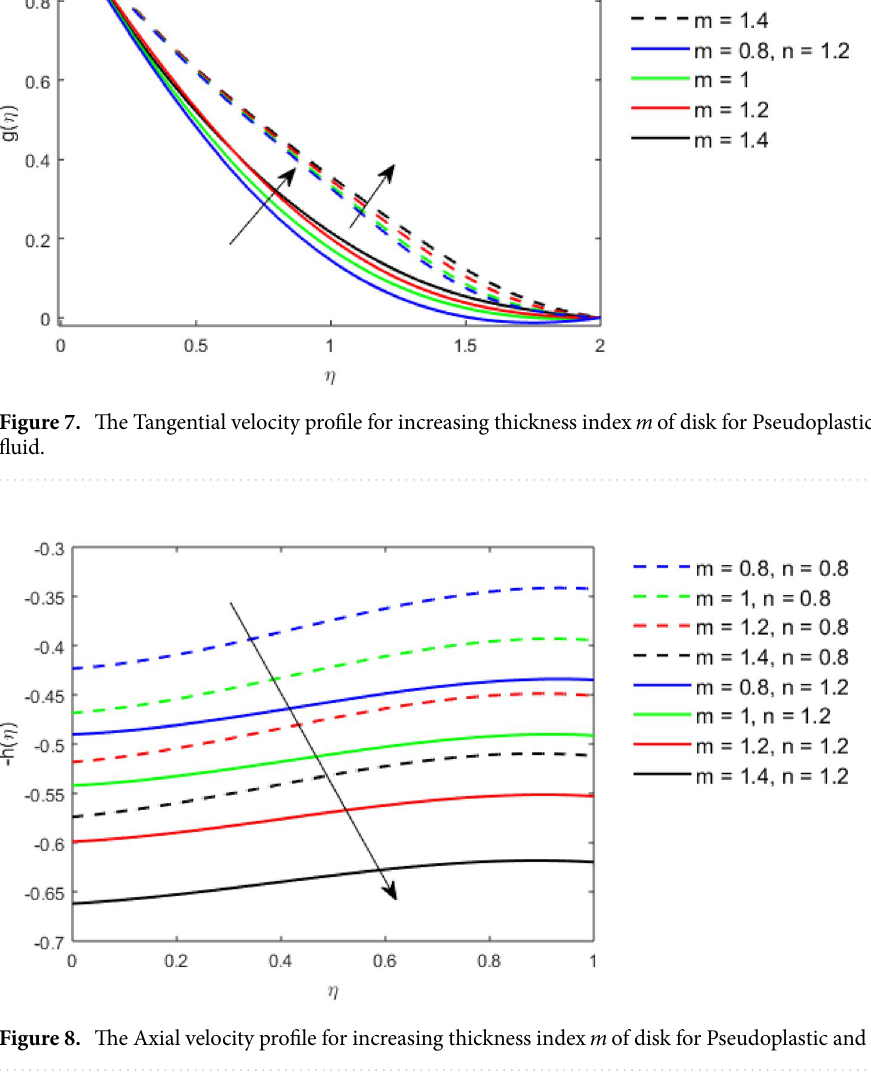
0.5 to k 1 . The reaction rate boosts up because of the wider absorption interfacial syrface variation in k vs vs = = area on porous media. Additionally, the nanoparticles of reactants become more accelerated and collide much faster than before, causing the thickness of the concentration boundary layer. Therefore, a decline in concentra- tion profile is witnessed. Figure 17 is the depiction of variation in drag force coefficient in the radial direction 0.8, 1.5, 2.5 . Figure 18 represents the for non-Newtonian rheology by taking the thickness index of the disk m = drag force coefficient in tangential direction for non-Newtonian rheology by taking the thickness index of disk 0.8, 1.5, 2.5 . Both figures show the enhancement in drag force coefficient in radial and tangential direction m = respectively. Heat transfer rate for non- Newtonian rheology is presented in Fig. 19 by escalating thickness index 0.8, 1.5, 2.5 . The decline in rate of heat transfer is witnessed for the power-law index n throughout 0.3 of disk m = to 1.2. Figure 20 is the sketch of heat transfer rate for non-Newtonian rheology for mounting values of Prandtl number. Heat transfer rate is seen to increase by increasing Prandtl number. Figure 21 presents the heat transfer rate for increasing value of the power-law index. ) for Newtonian fluid with thickness h ( Table 1 is developed for numerical values f ′ ( 0 ) , g ′ ( 0 ) , θ ′ ( 0 ) and − ∞ 0, and Pr 0 and Ma , K , k 1 , k 2 , k 2, r 0.6 . The results obtained are found in excellent index of disk m vs = = = = ) h ( agreement with the previous literature. Table 2 signifies the numerical results of f ′ ( 0 ) , g ′ ( 0 ) , θ ′ ( 0 ) and − ∞ for varying dimensionless thickness coefficients and power-law index. The results show that variations in the dimensionless thickness coefficient do not make any effect. However, increasing power-law index causing an ) . h ( increase in f ′ ( 0 ) , g ′ ( 0 ) , θ ′ ( 0 ) and − ∞